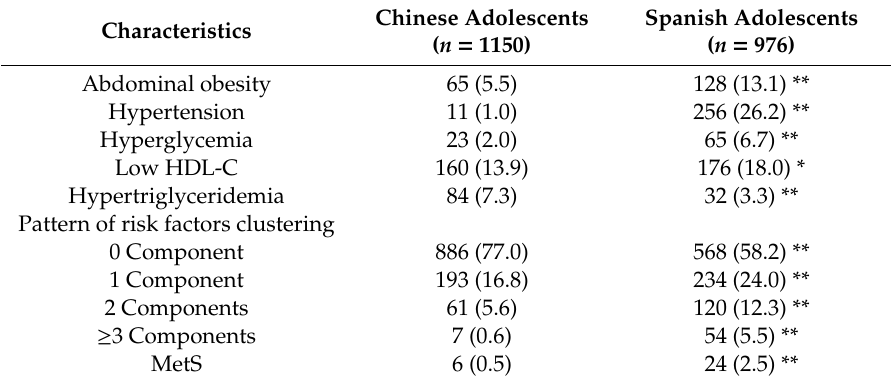
Table 2. Prevalence of metabolic syndrome and its components in Chinese and Spanish adolescents. Characteristics